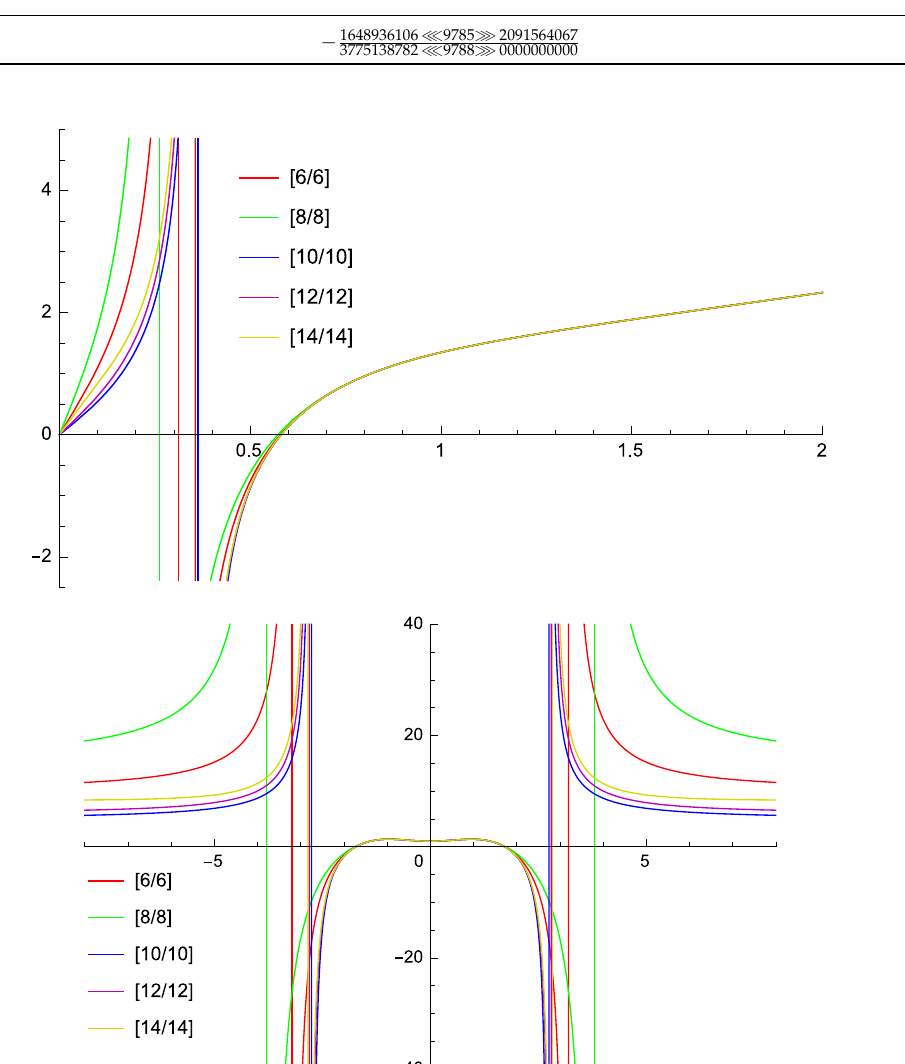
( ν ) (top) and [ L / L ] ν ( ν − 1 ) (bottom) for 6 L E E / ν ≤ ≤ (cid:0) (cid:1) ν − 1 / ν is an even function of ν − 1